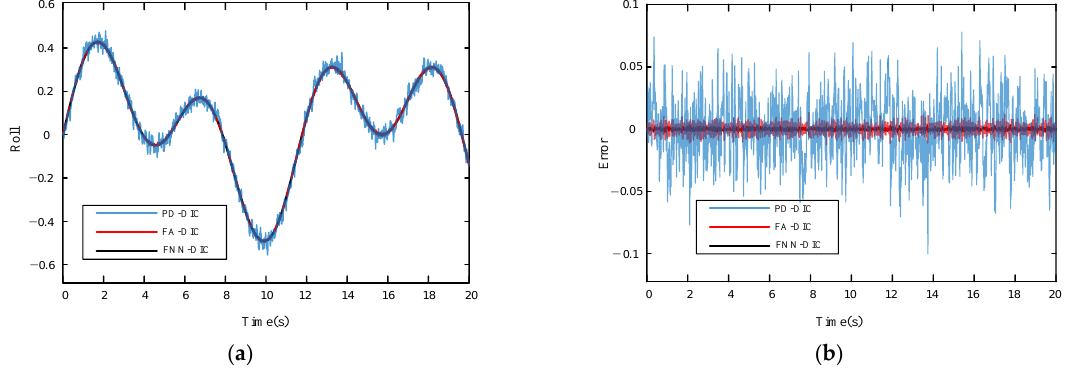
Figure 11. Roll angle tracking results under atmospheric disturbance: ( a ) Roll angle tracking curve, and ( b ) tracking error curve.